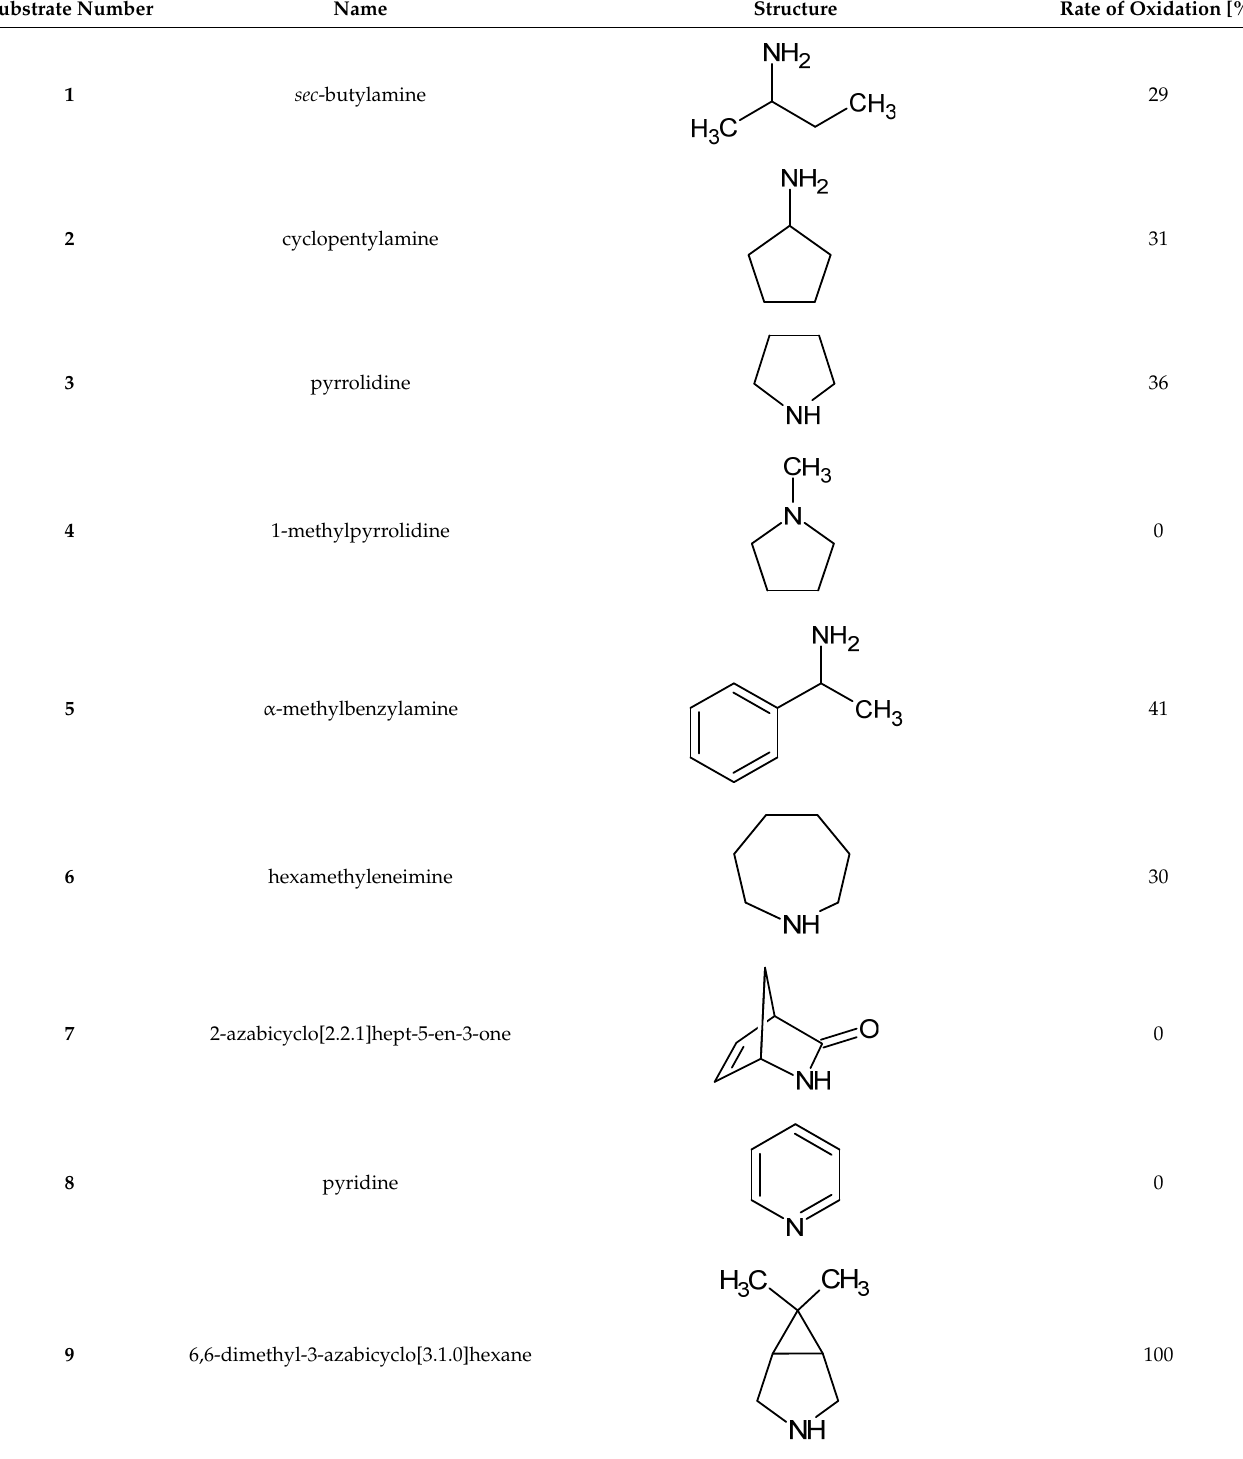
Table 2. Relative rates of oxidation by MAO P3 for various amine substrates. Bioconversions were performed in 10 mM potassium phosphate buffer pH 7.2, with a 10 mM concentration of substrate using the cell-free intracellular protein extract of the P3 strain. Rates are relative to the highest reaction yield, 89%, which was noted for 6,6-dimethyl-3azabicyclohexane (compound 9). The relative rate of oxidation was set to 100% for this compound and all the other rates were calculated relative to compound 9.